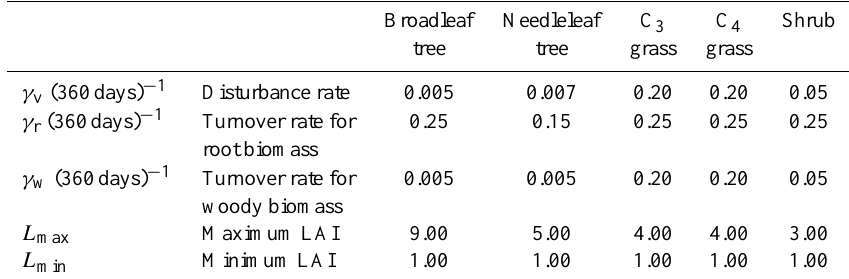
woody biomass Maximum LAI Minimum